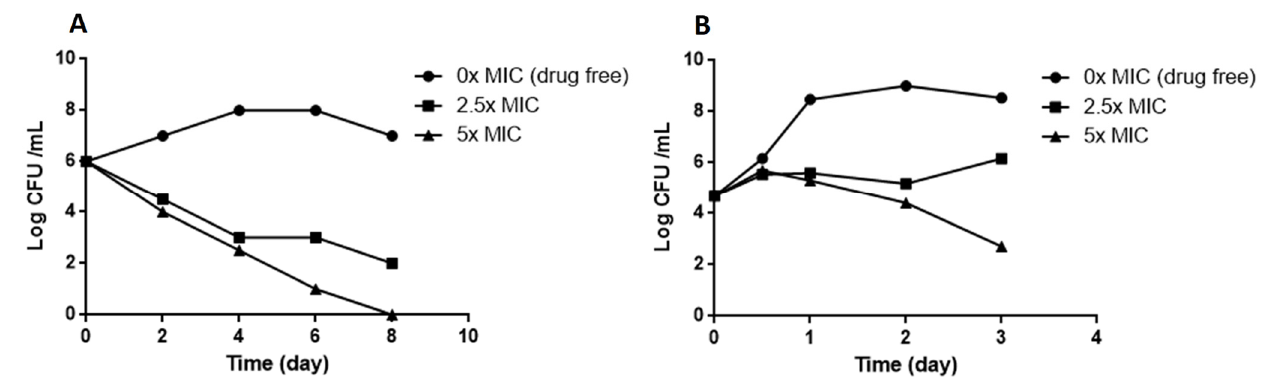
Figure 3. Kill kinetics for compound 1 . Exponential cultures of M. bovis BCG ( A ) and M. smegmatis ( B ) were exposed to various concentrations of compound 1 in 7H9 medium and the number of viable bacteria were determined by serial dilution and plating onto agar 7H11 plates at the indicated times. The control (drug free) was 0.5% DMSO.